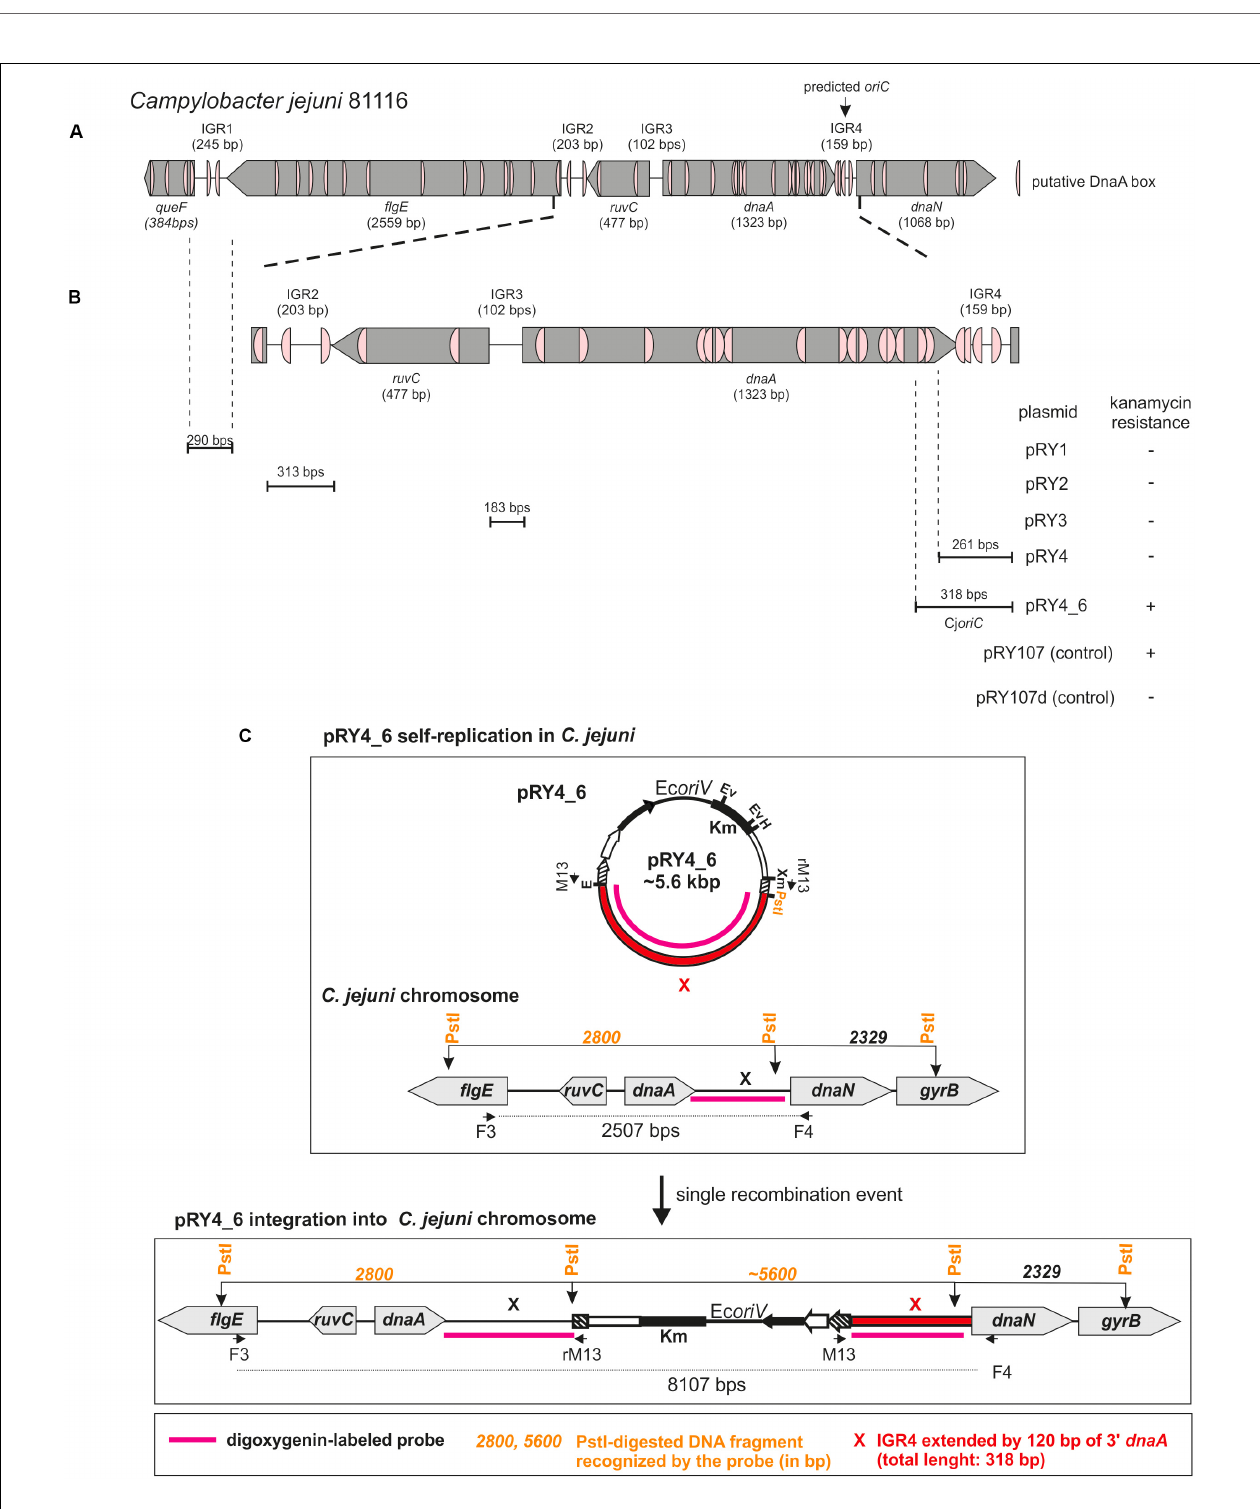
FIGURE 1 | Identification of Campylobacter jejuni oriC . (A) Schematic presentation of a chromosomal region containing predicted oriC (Gao et al., 2013). The genes and intergenic regions (IGR) are drawn to scale with sizes indicated in brackets. Putative DnaA boxes identified according to the Epsilonproteobacterial DnaA box consensus sequence (Jaworski et al., 2016)) are marked. (B) Schematic presentation of the results of oriC -plasmid maintenance analysis. IGR regions cloned into non-replicating pRY107d are presented below the chromosomal scheme. Plasmids were introduced into C. jejuni cells by conjugation (see section “Materials and Methods”). Plasmids conferring C. jejuni resistance to kanamycin are marked by “+,” while “–“ denotes – no growth of C. jejuni conjugates on kanamycin. (C) Possible scenarios of oriC plasmids’ fate in C. jejuni . Plasmids containing oriC can self-replicate or incorporate into C. jejuni chromosome via single crossing over. In each case it will confer C. jejuni resistance to